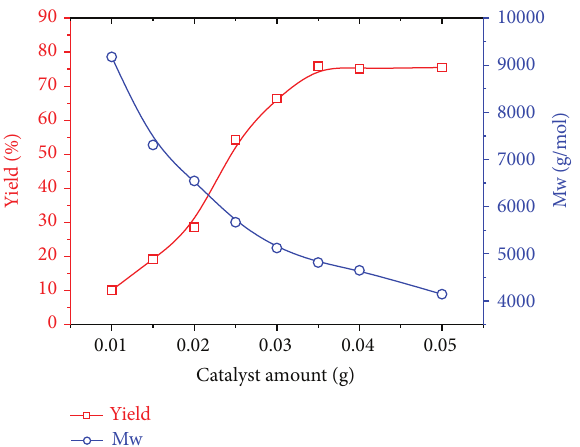
Figure 7: Effect of reaction time on the conversion and molecular weight of PCHO in CH 2 Cl 2 at 40 ∘ C over H 3 PW 12 O 40 .